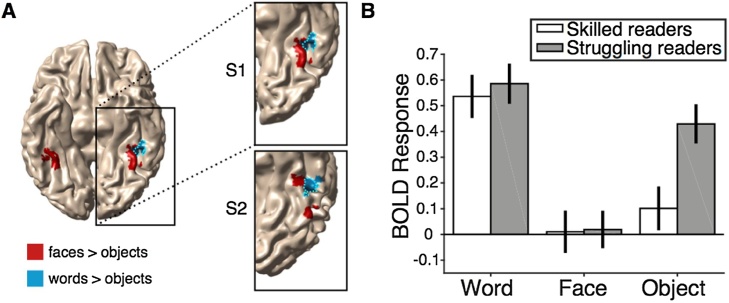
BOLD responses in the VWFAface. (A) The FFA is shown in red, VWFAobj is shown in blue, and VWFAface is outlined in cyan for two example, skilled reading, subjects. Note that the two ROI definitions are overlapping indicating that in skilled readers both contrasts identify the same word-selective patch of cortex. (B) BOLD responses (beta weights from the GLM) for each stimulus category (word, face, and object) in skilled (white) and struggling (gray) readers. Skilled readers show word-selective responses (words > objects) while struggling readers show very weak word selectivity in this region with a comparable response to words and objects. The error bars represents the SEM across subjects.